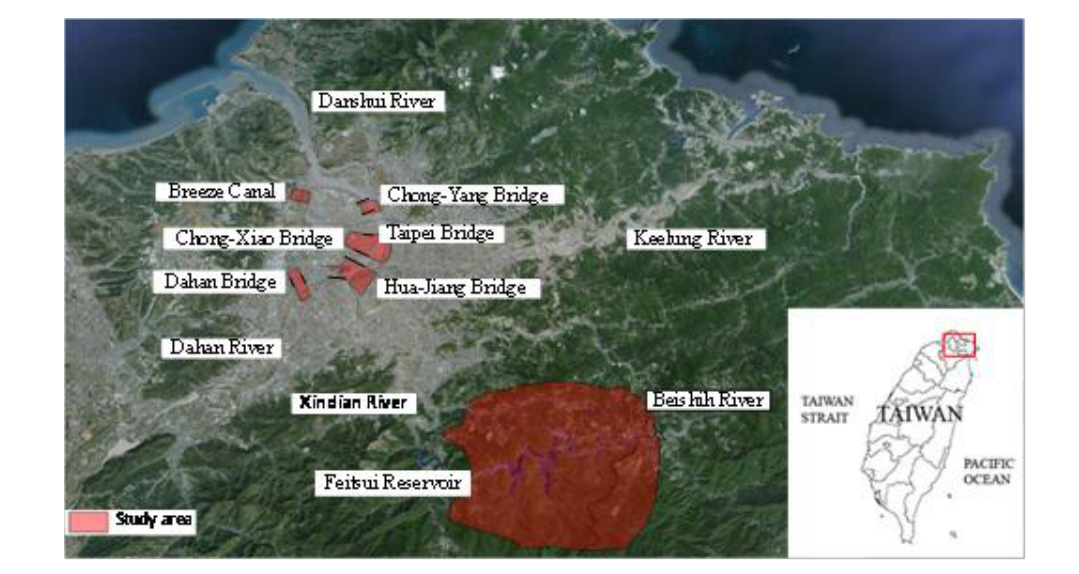
Figure 3. The stream network and basin of Danshui